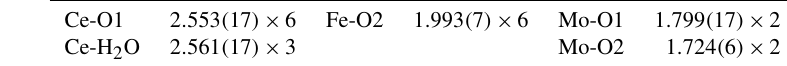
Table 6. Selected bond distances in the average cubic structure of tancaite-(Ce).